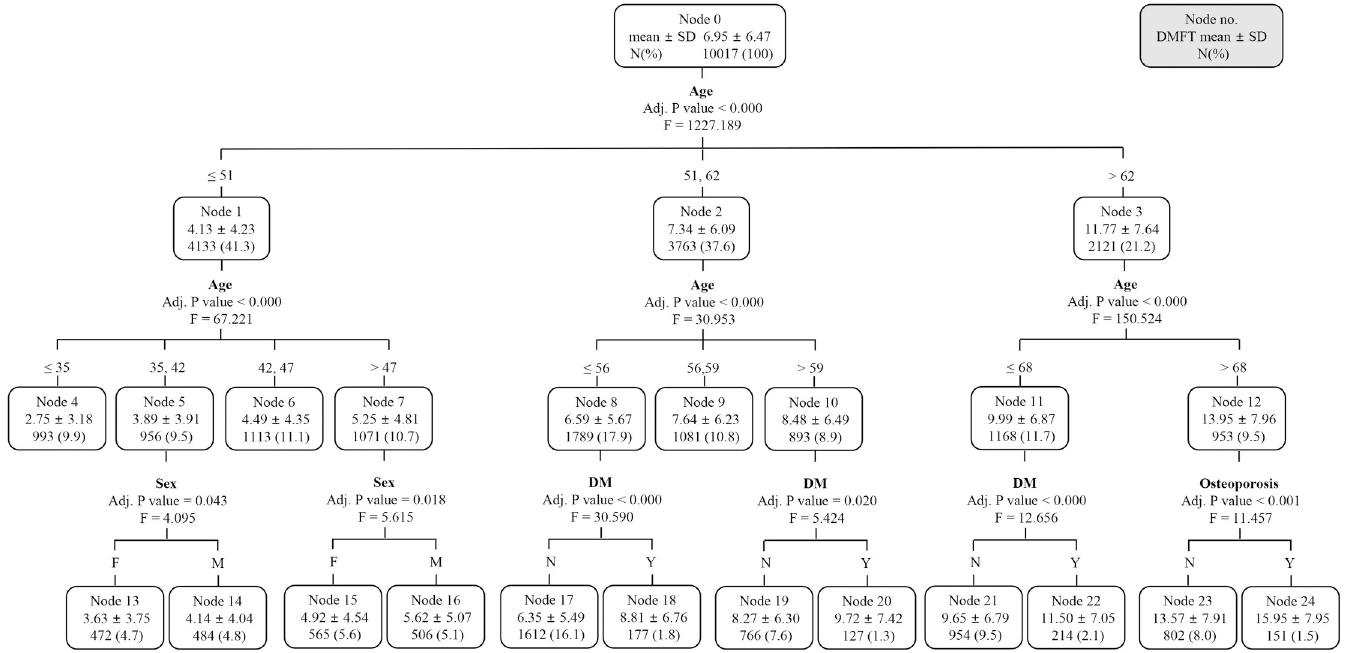
Fig 1. A chi-square automatic interaction detection classification tree analysis to identify the predictors related to the DMFT of all subjects. Data were presented as mean ± standard deviation. F, female; M, male; DM, diabetes mellitus.